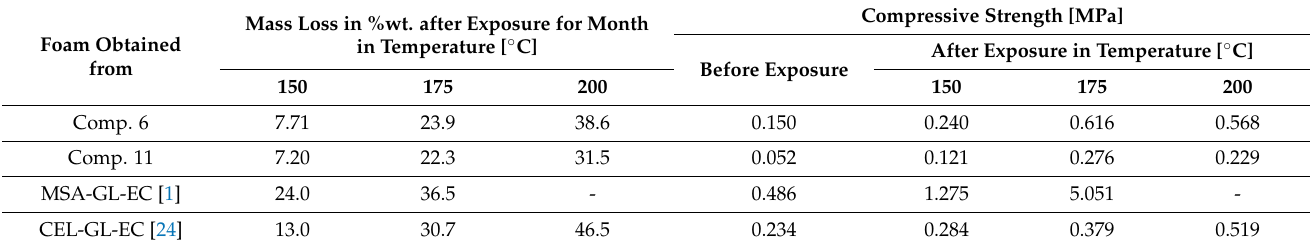
Table 7. Thermal resistance and compressive strength of the